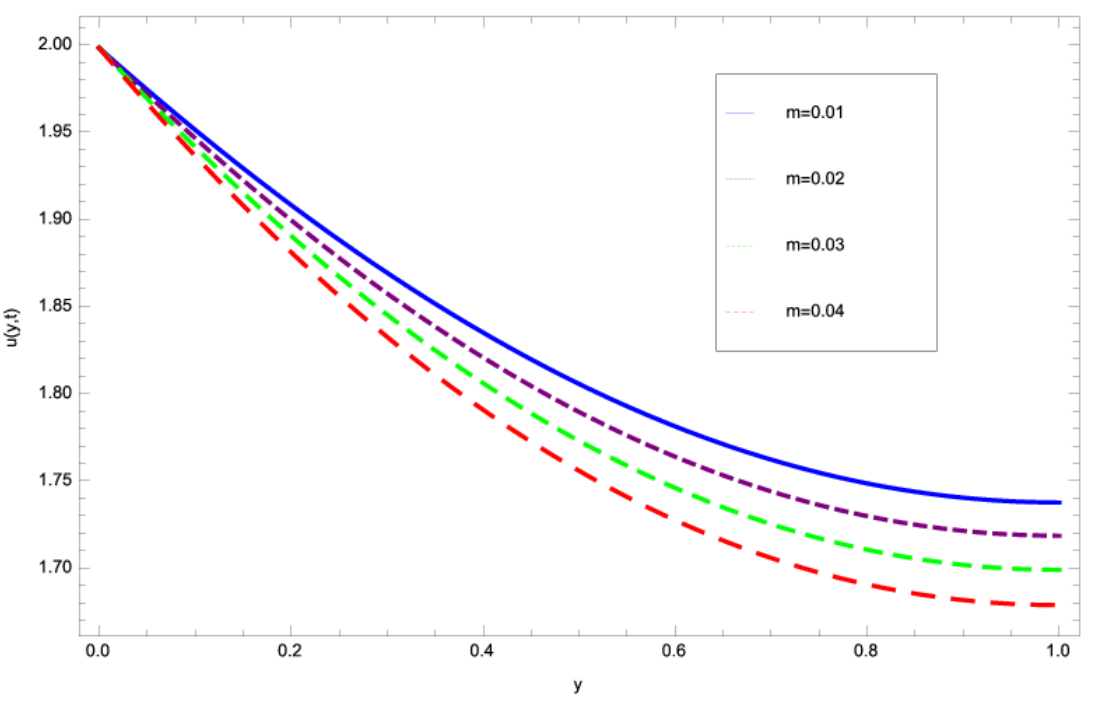
Figure 9. The effect of the gravitational parameter during fluid motion, when ω = 0.6; W e = 5; 0 . 6 ; M = 0.6; t = 3.5. Appl. Sci. 2017 , 7 , 369